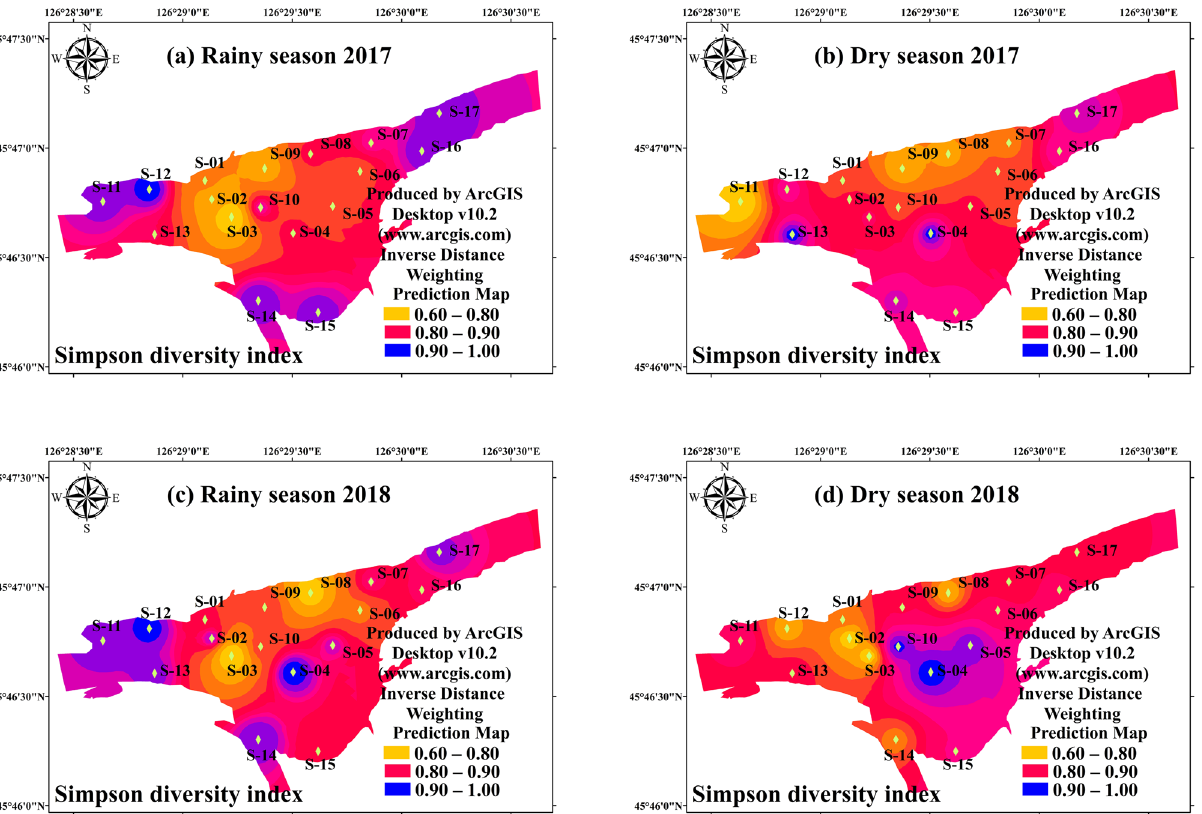
Figure 6. The spatial distribution of phytoplankton Simpson diversity index in study period. ( a ) Rainy season (July 2017); ( b ) Dry season (October 2017); ( c ) Rainy season (July 2018); ( d ) Dry season (October 2018). The interpolation map was constructed by ArcGIS software using the Inverse Distance Weighting method. The maps were created using software ArcGIS Desktop v10.2 (www.arcgi s.com).